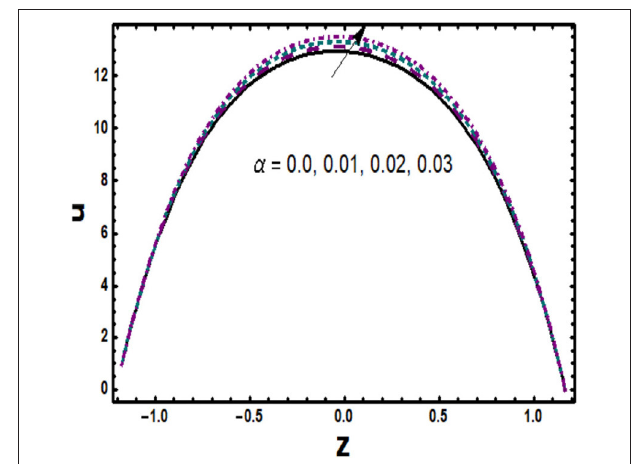
FIGURE 4 | Effects of α on u ( z ) .